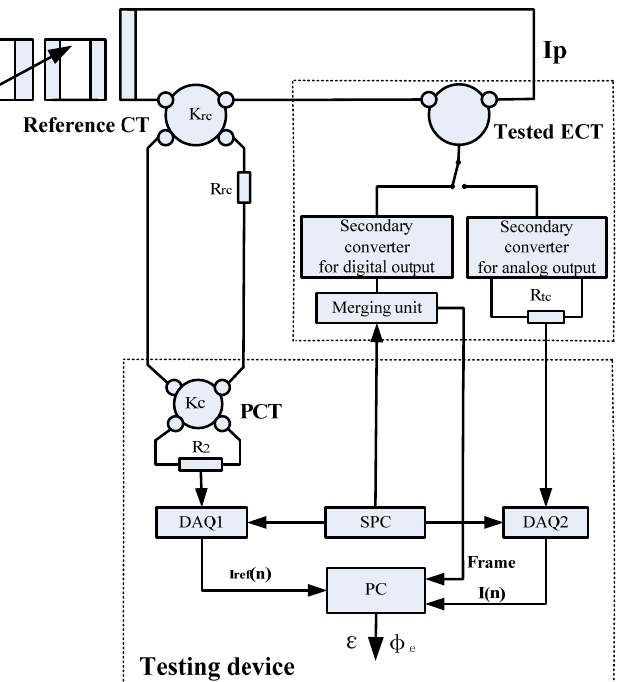
Figure 2. Block diagram of testing